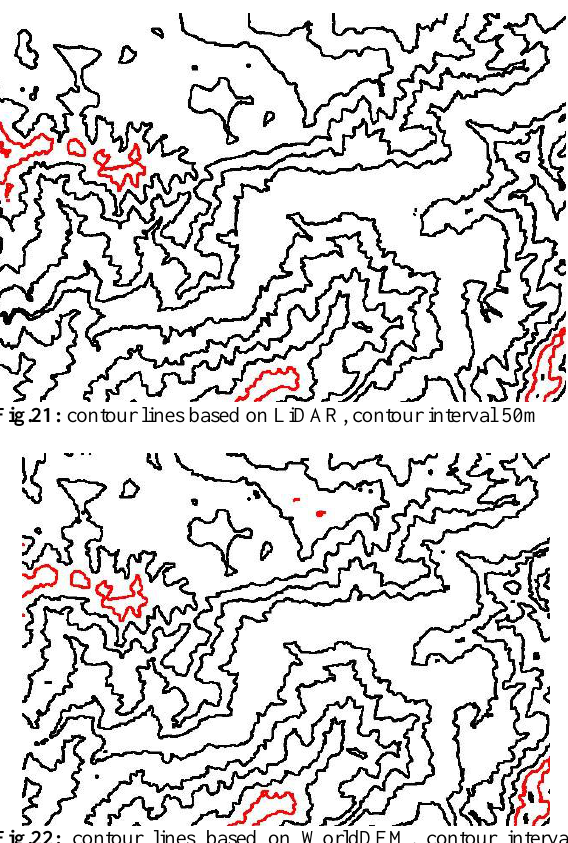
Fig.21: contour lines based on LiDAR, contour interval 50m